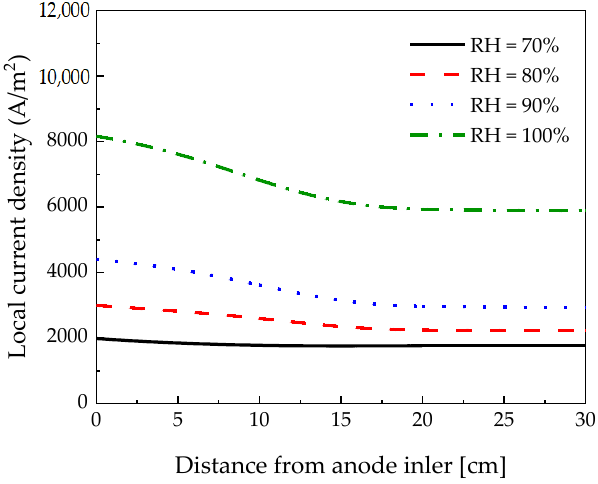
Figure 15. Local current density measured along the channel length according to the relative humidity at 0.18 V.